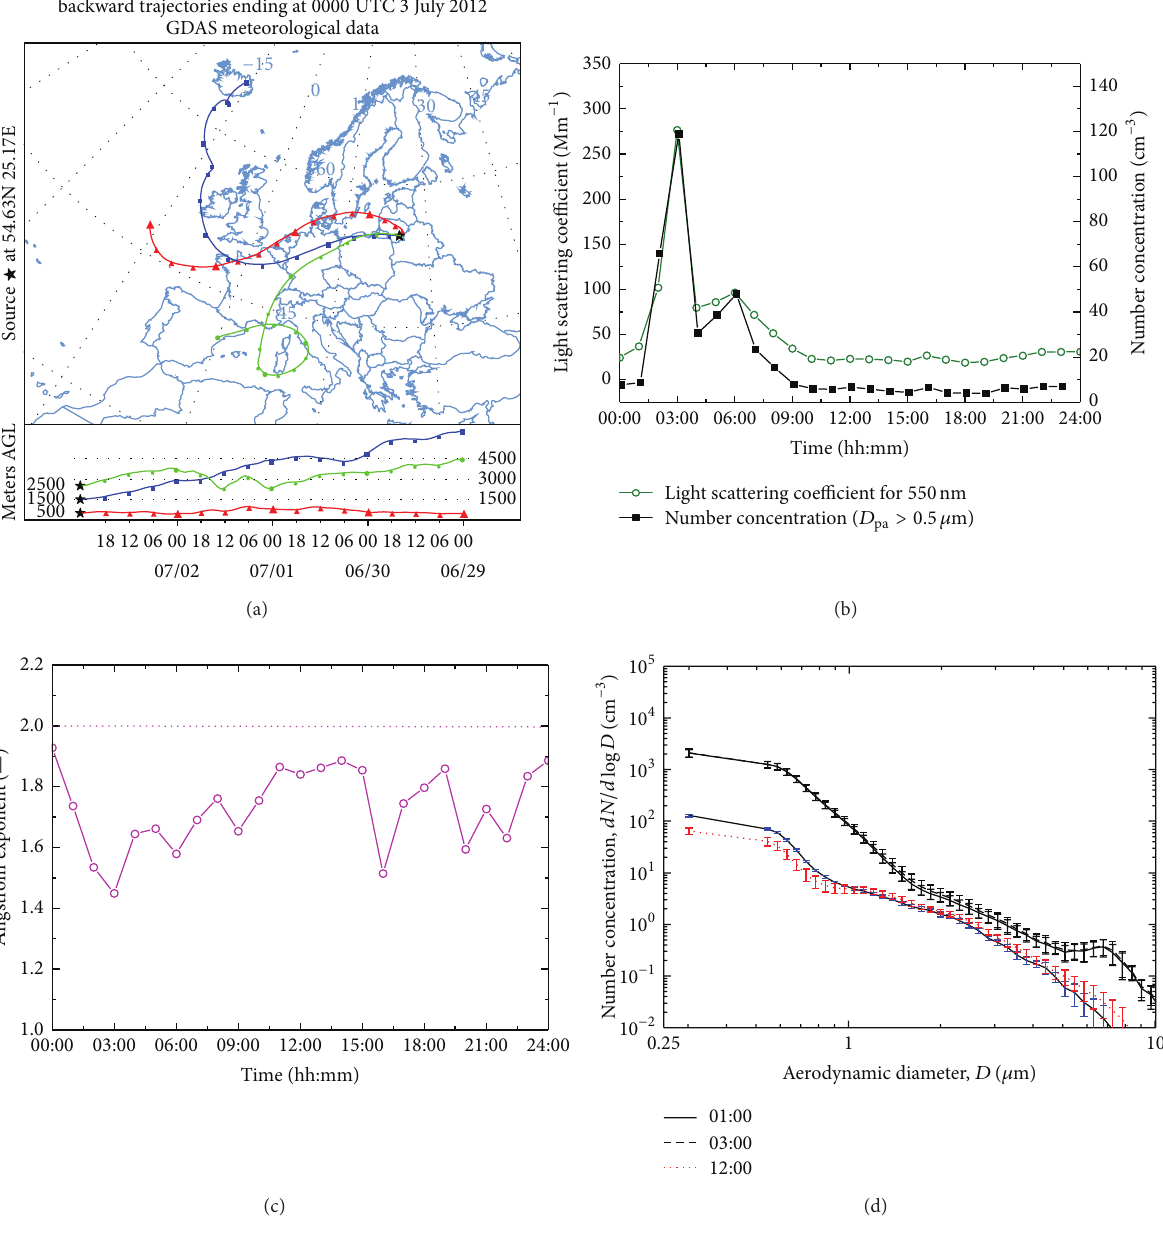
Figure 6: (a) Air parcel trajectory analysis from the National Oceanic and Atmospheric Administration (NOAA) Air Resources Laboratory (ARL) HYSPLIT model. For this analysis, the model was run backwards for 96 hours from 3 July 2012 at 00 UTC. Traces show the origin of air parcels at Vilnius at the 500 m (red), 1500 m (blue), and 2500 m (green) levels. (b) The variation of the measured and hourly averaged values of the light scattering coefficient at 550 nm and the particle number concentration. (c) The ˚Angstr¨om exponent for 450 and 700 nm wavelength pair. (d) The particle size distributions.